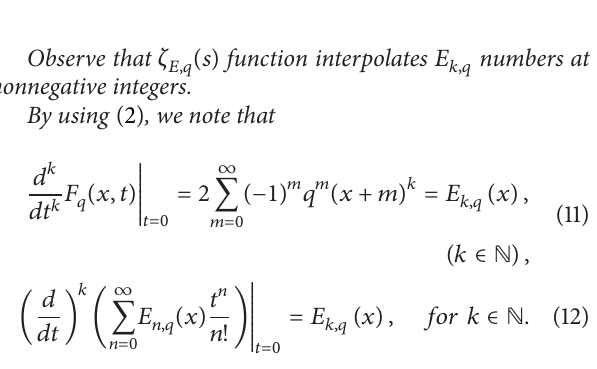
Figure 1: The curve 𝐸 𝑞 (𝑠) runs through the points of all 𝐸 𝑛,𝑞 except 𝐸 0,𝑞